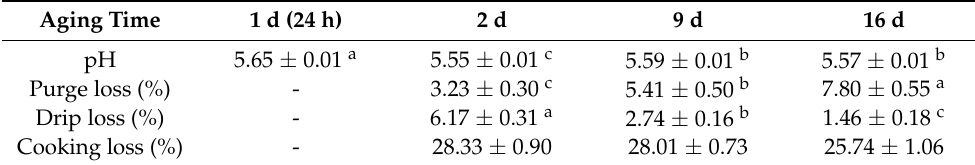
Table 1. The pH and water-holding capacity changes of pork loins during postmortem aging. Aging